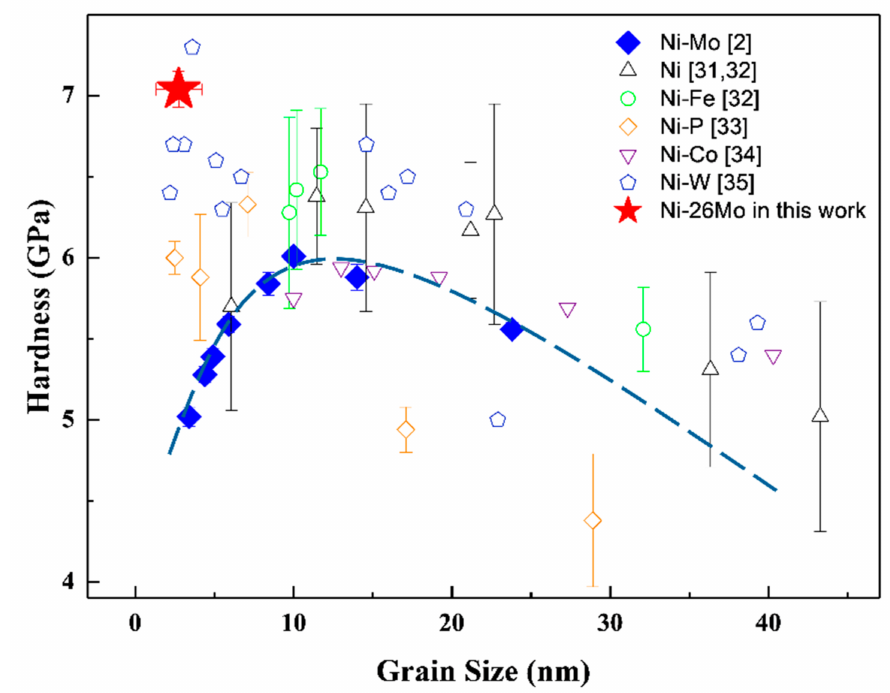
Figure 3. Hardness in NC/NCAM Ni-Mo alloy. Variation of microhardness data with grain size of electrodeposited NC Ni and Ni alloys from literature. The red star represents the microhardness of Ni-26Mo. The blue dotted line representing a deviation from Hall-Petch when grain size goes below about 10